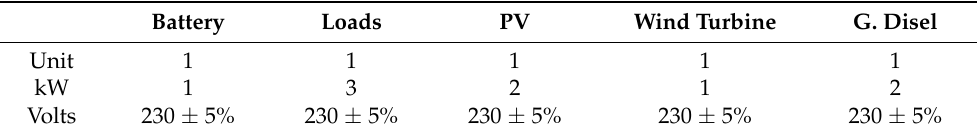
Table A1. The parameters of the microgrid